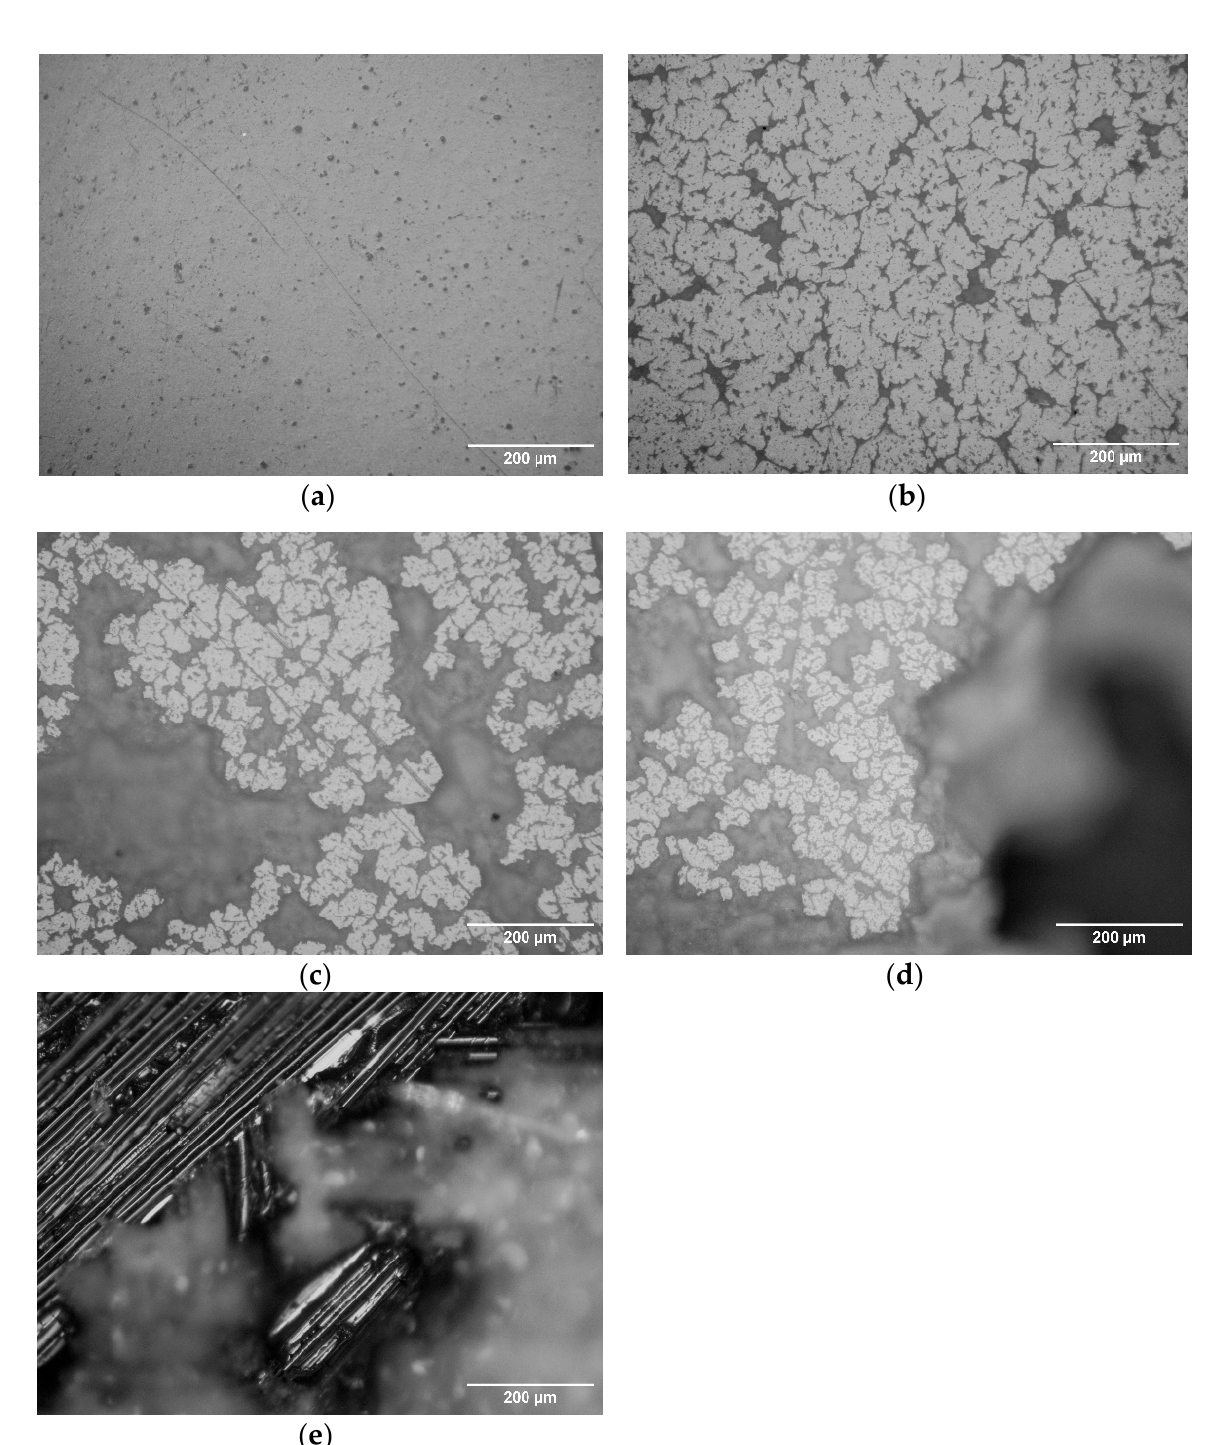
Figure 9. Microcopy image of representative sample with coating A at ( a ) stage 1; ( b ) stage 2; ( c ) stage 3; ( d ) stage 4; ( e ) stage 5. Figure 10 presents a microcopy image of a representative sample with coating B after each erosion